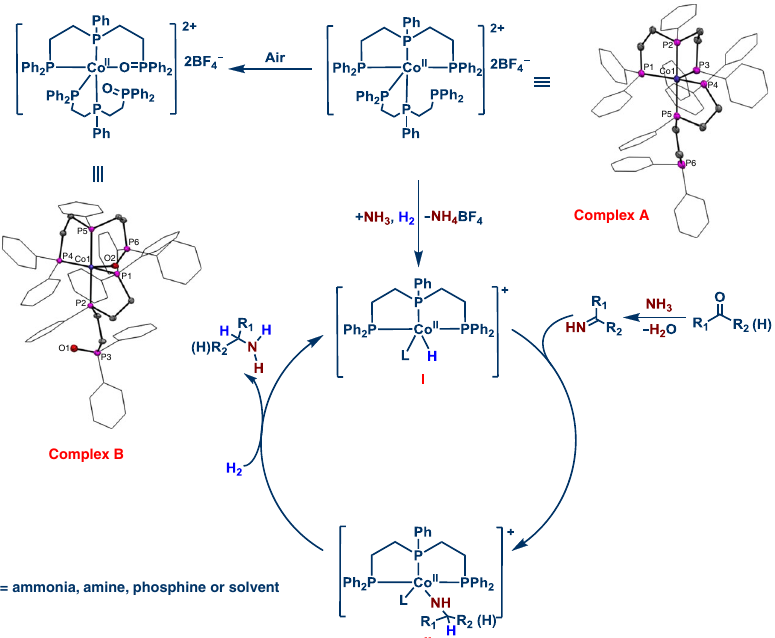
Fig. 4 Proposed reaction mechanism for the Co-triphos catalysed reductive amination. Molecular structure of the cation of complexes A and B. Displacement ellipsoids are drawn at the 30% probability level; phenyl rings are shown as wireframe; hydrogen atoms are omitted for